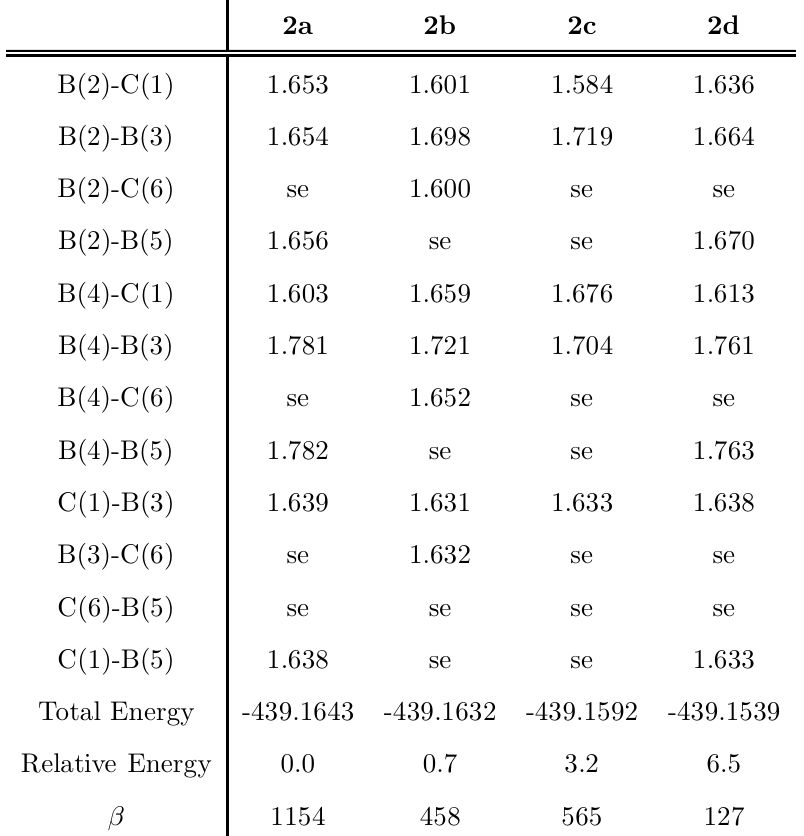
Table 1 (Second half) Main bond lengths (¸A), total energies (au), relative energies (kcal/mol) and molecular hyperpolarizabilities (au) of conformers 1a-d and 2a-d . (For unsubstituted 1-6-C 2 B 4 H 6 , bond lengths are 1.625 ¸A for B-C and 1.713 ¸A for B-B bonds). Relative energies are calculated assuming energy for 1a for CCCARB and for 2a for BBCARB to be